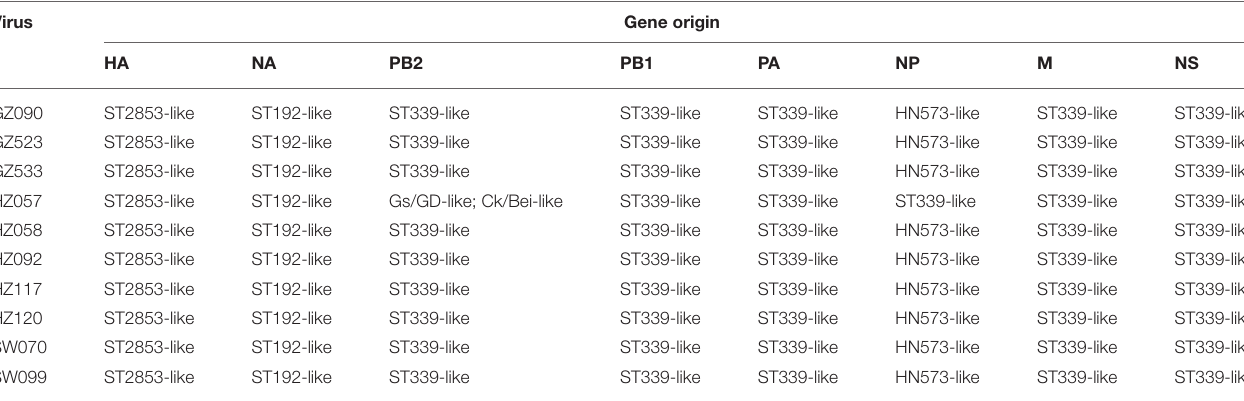
TABLE 2 | Gene composition of H6N6 subtype influenza viruses isolated from LPM in Guangdong*.